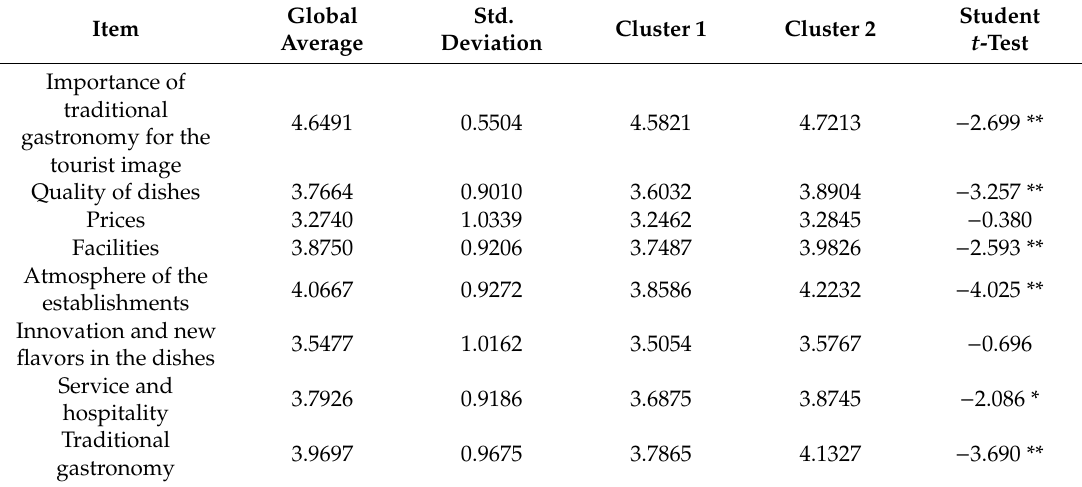
Table 7. Di ff erences by cluster regarding the perception of the gastronomy and the characteristics of the food market